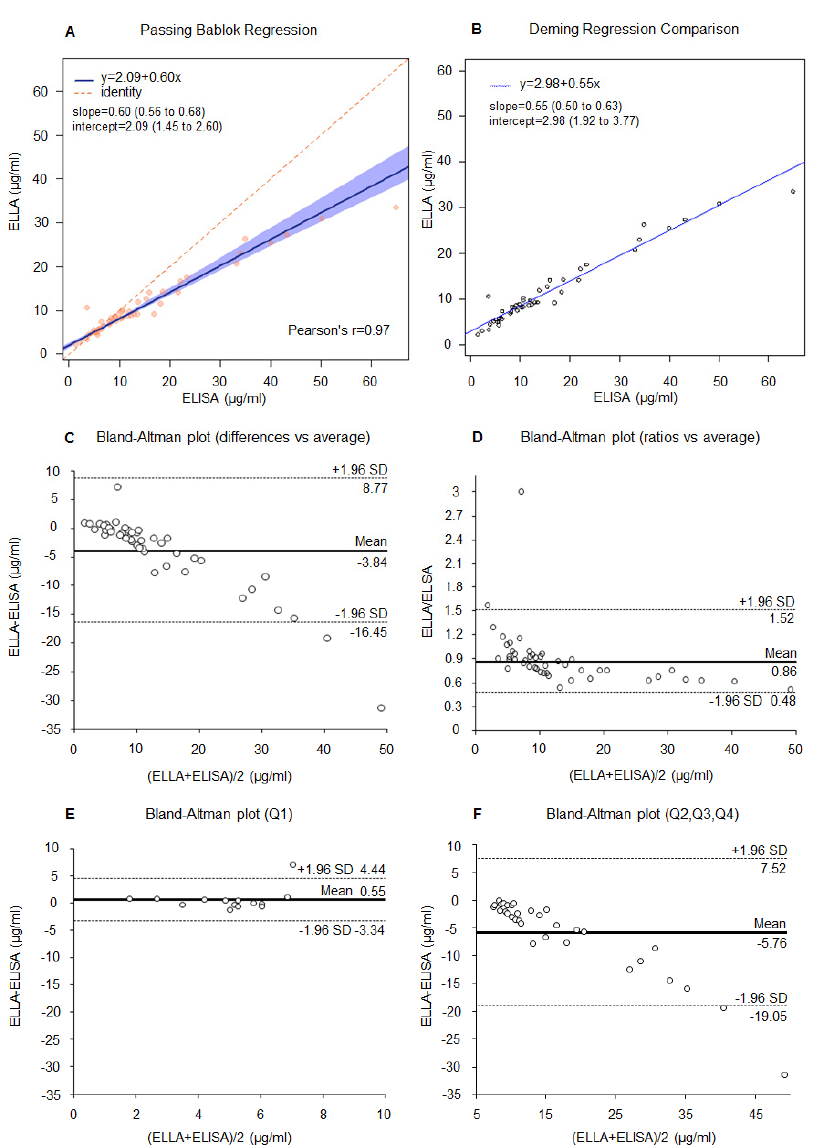
Figure 1. Correlation between ELLA (3-step dilution protocol) and ELISA for adiponectin measure- ment ( n = 46). ( A ) Passing–Bablok and Pearson’s r coefficient, ( B ) Deming regression, ( C ) Bland– Altman plot (differences vs. average), ( D ) Bland–Altman plot (ratio vs. average), ( E ) Bland–Altman plot (differences vs. average) for adiponectin < 6.75 µ g/mL (<first quartile Q1), and ( F ) for adiponectin ≥ 6.75 µ g/mL ( ≥ first quartile, Q2-3-4). Dashed lines represent 95%